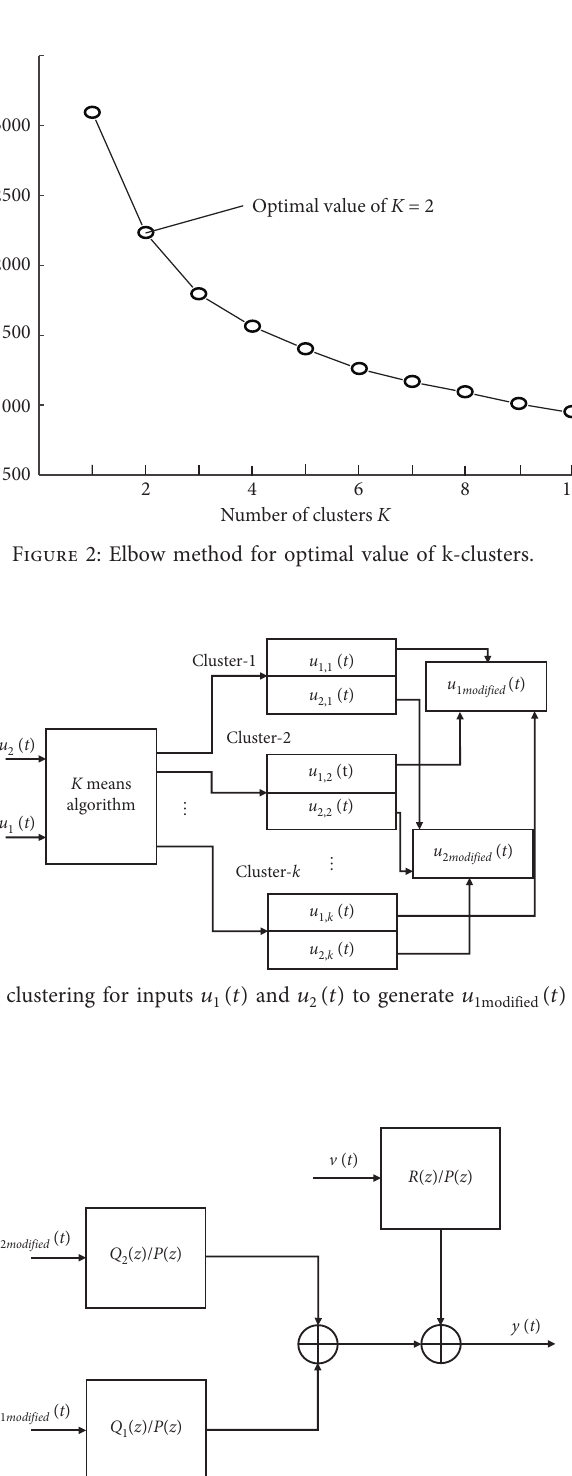
Figure 4: Proposed system model with modified inputs signals u